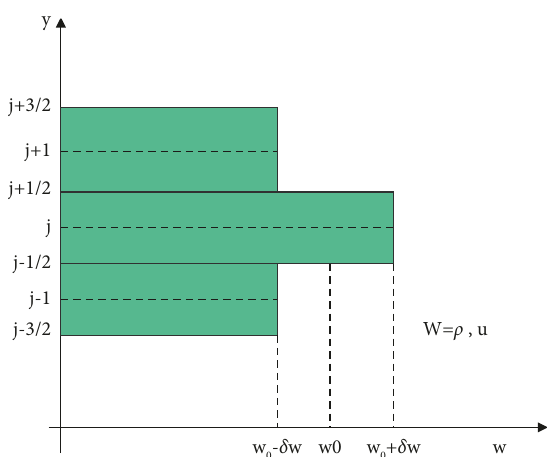
Figure 1: Schematic diagram of steady-state discontinuity.